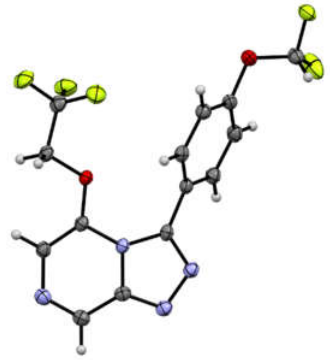
Figure 2. ORTEP drawing of compound 3 .